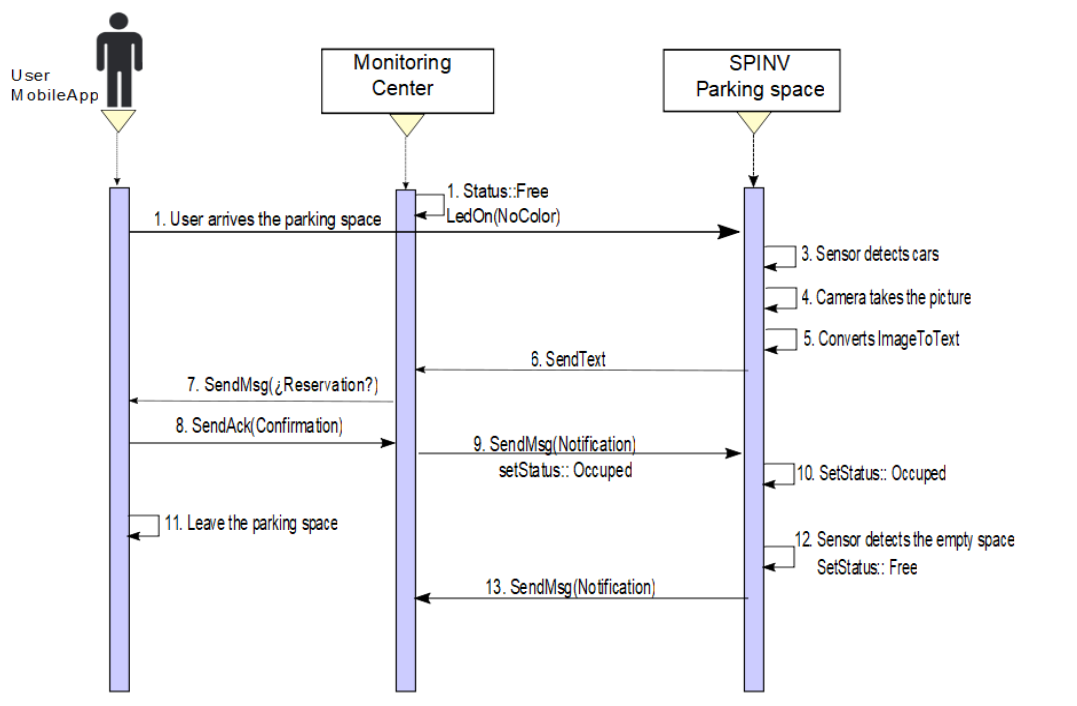
Figure 9. Sequence diagram of Scenario 3a. There is no reservation, a car arrives to the space, and the user/driver has the